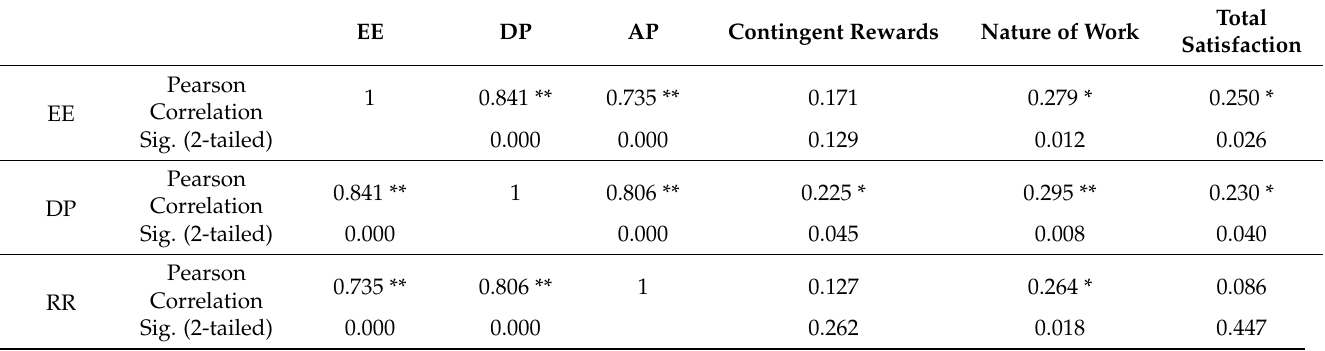
Table 6. Correlations between burnout scales and job satisfaction, nature of work and fringe benefits.